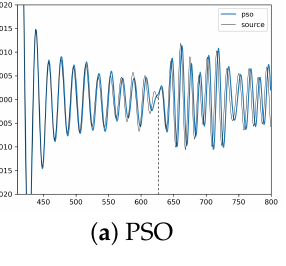
Figure 7. The trace of PSO, CDPSO, KH, and source within 300 ms. In a nutshell, the KH shows the best performance among the three